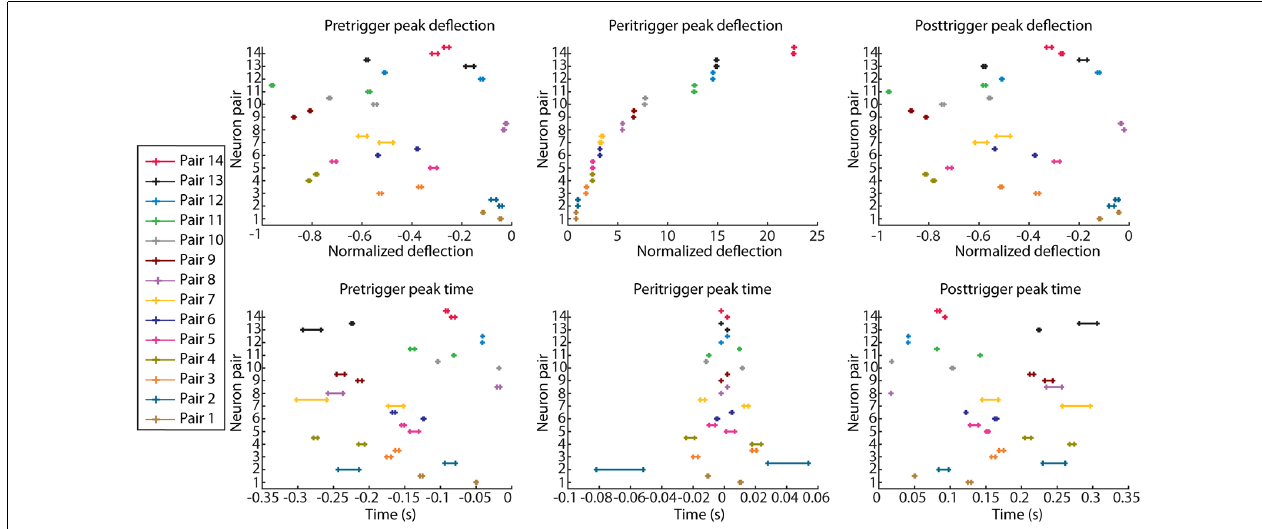
FIGURE 2 | Parameter values quantifying the correlation patterns for all neuron pairs. Each correlation pattern was quantified based on the peak time and peak deflection amplitudes in the pretrigger, peritrigger, and posttrigger time periods. Neuron pairs were ordered based on their peritrigger peak deflection (top row, middle column). Note that each pair is represented two times, since each pair generates two correlation patterns, one for each triggering spike ( Figure 1B ). As the recorded data were bootstrapped for each pair of neurons, each parameter value is presented as a 95% confidence interval. Peak deflection values are the net changes in firing frequency from the baseline activity, divided by the baseline